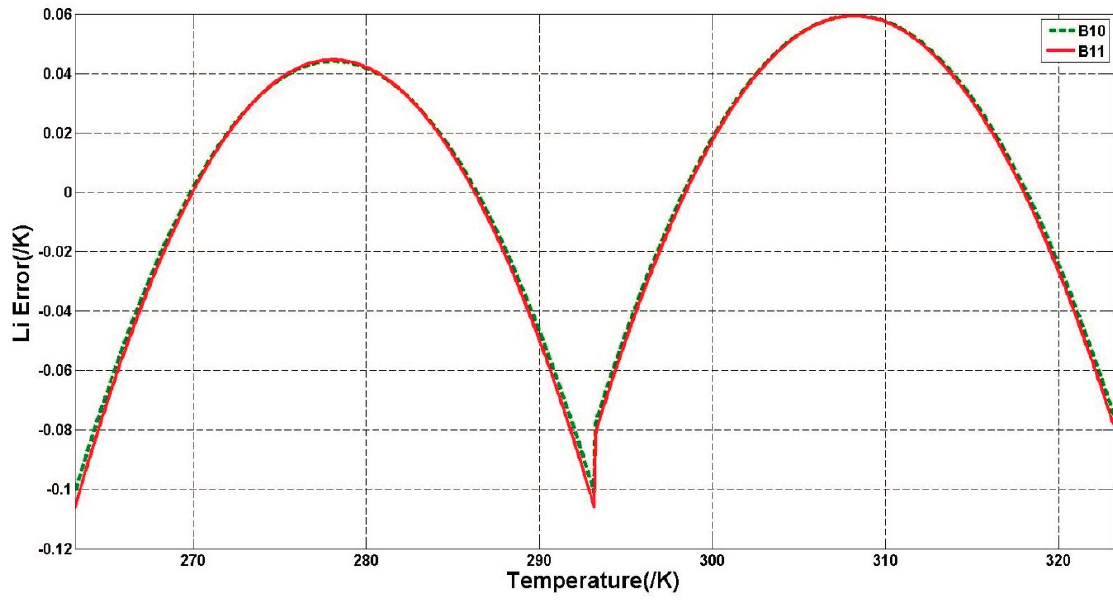
estimation error for piecewise linear Figure 5. L i